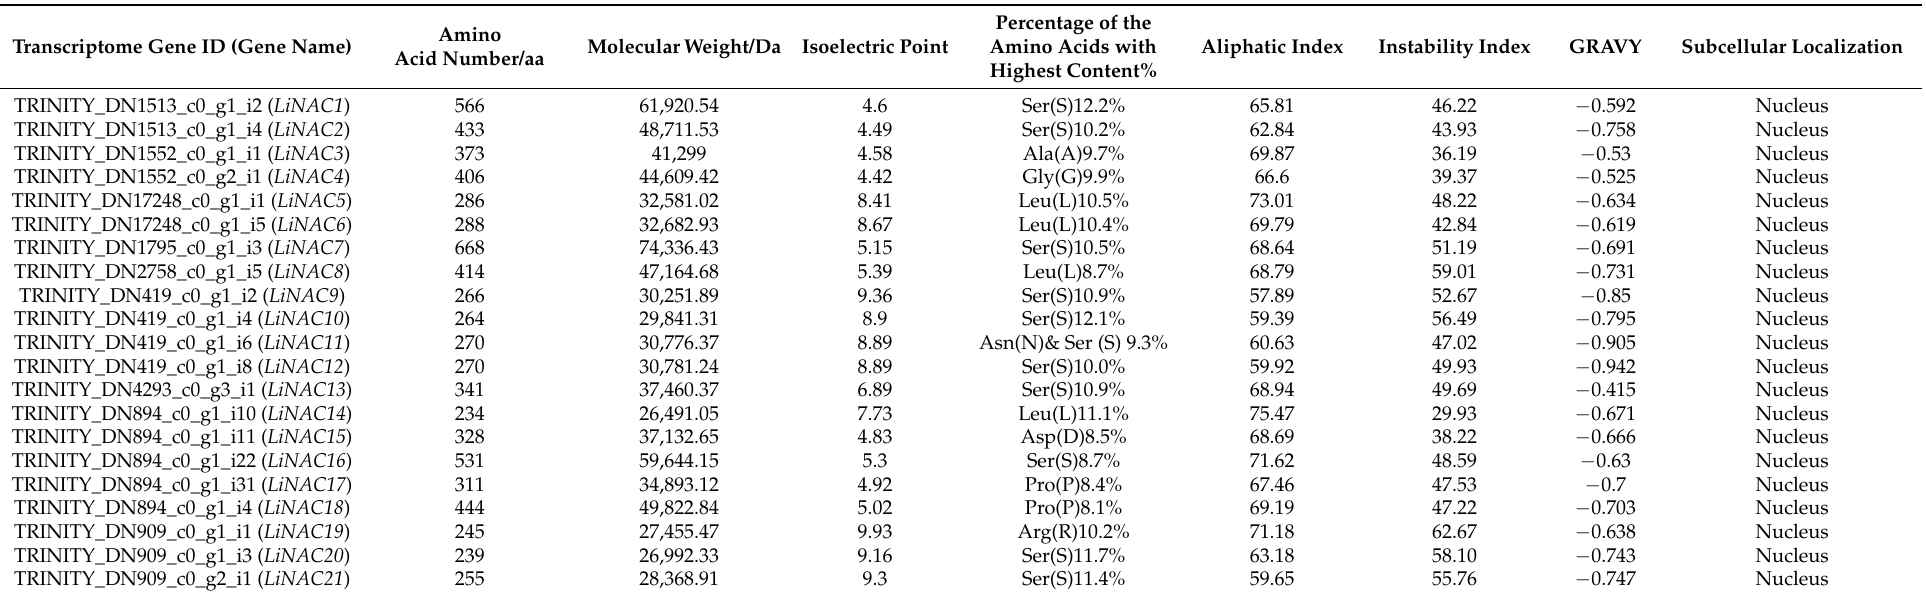
Table 1. LiNAC gene and protein